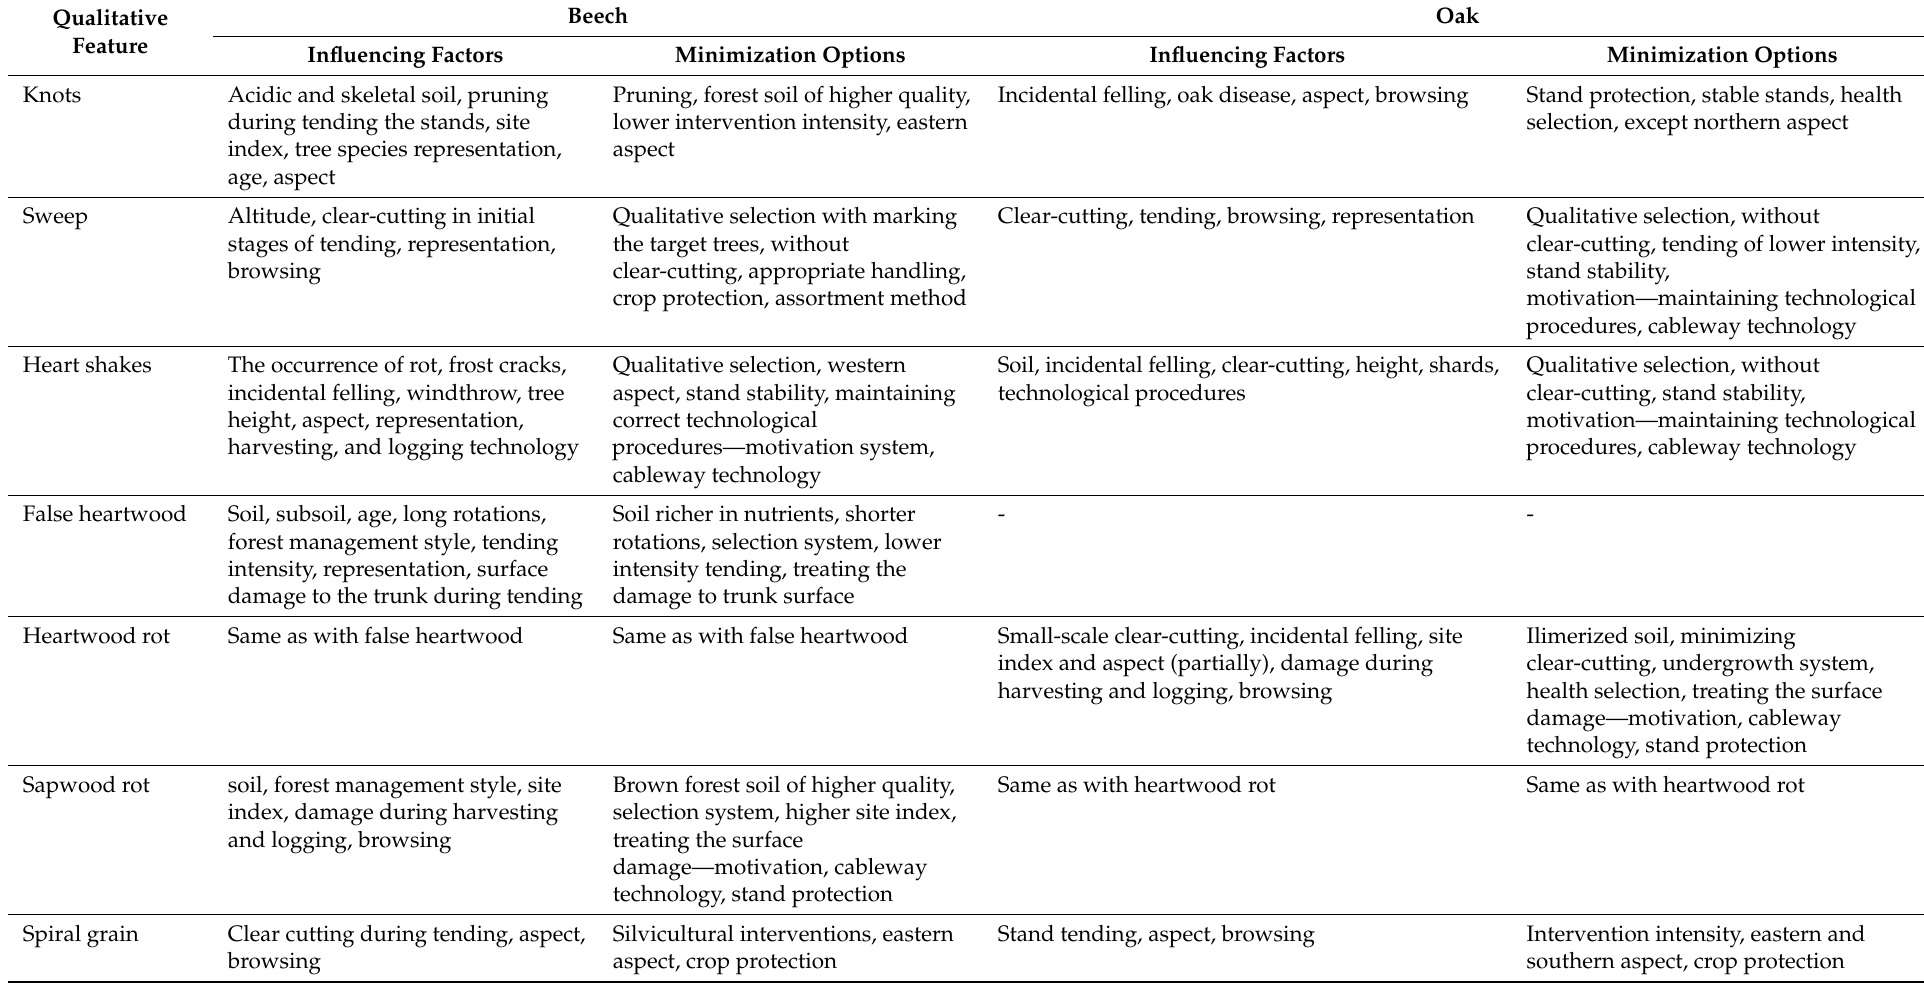
Table 4. Statistical dependence of the size of individual qualitative features of oak wood on selected numerical factors in individual forest